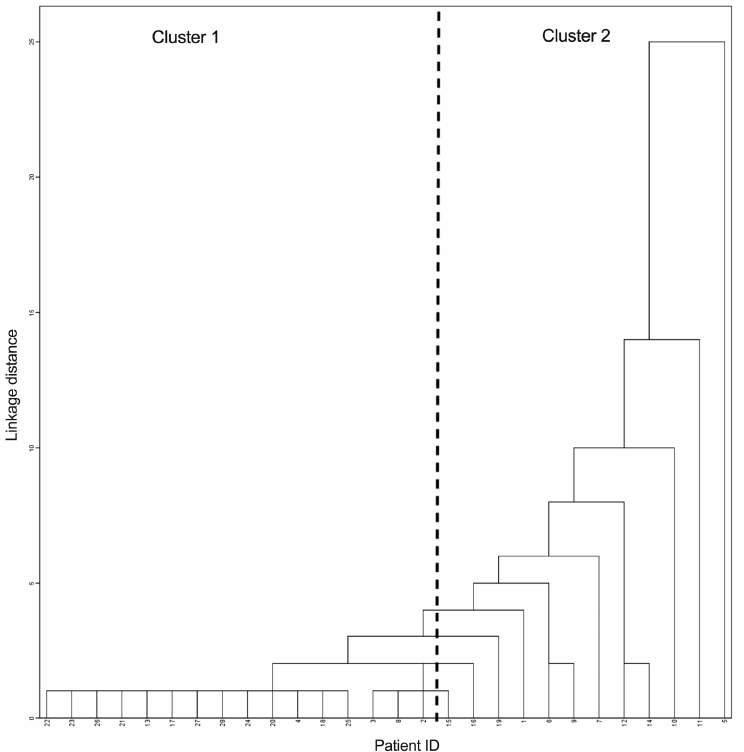
Figure 3. Dendrogram of breast cancer patients by the number of CTCs with different